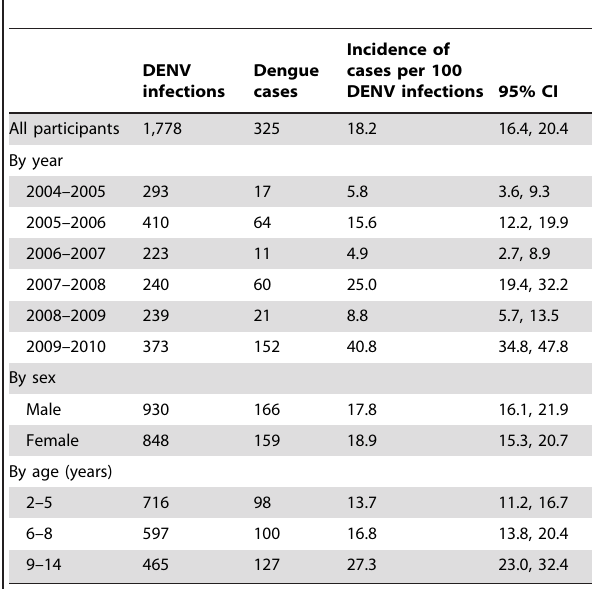
Table 5. Incidence of dengue cases among DENV infections, Managua, Nicaragua, 2004–2010.